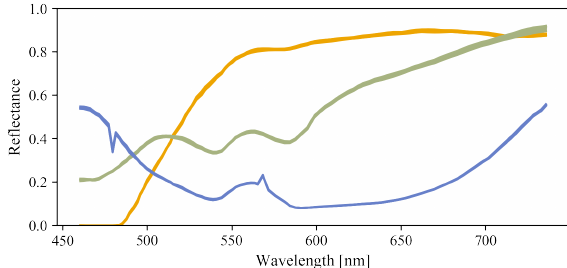
The spectra of the anomalous pixels on the Col- orChecker data, which are randomly distributed to the test dataset. The test dataset has the same dimensions as the train- ing set ( 50 × 50 × 100 ). Image is originally from (P¨ol¨onen et al.,